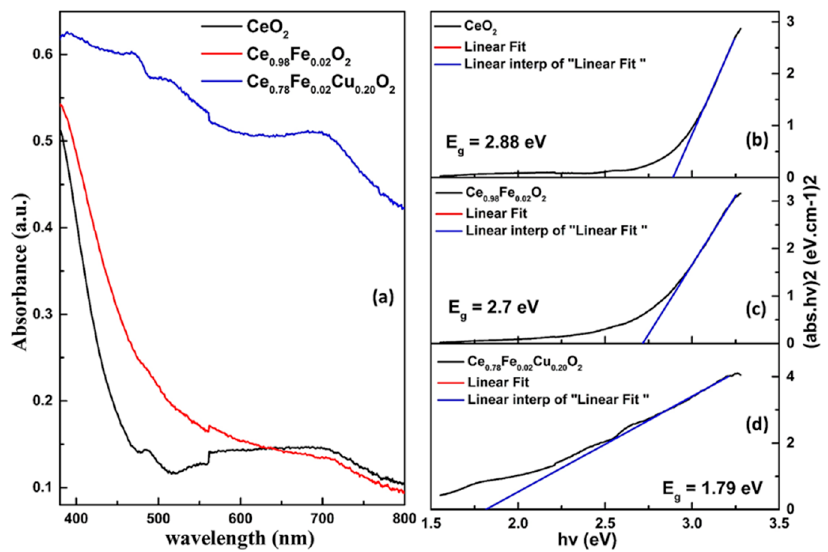
Figure 3. ( a ) UV–Vis absorption spectra of pure CeO 2 , Ce 0.98 Fe 0.02 O 2 , and Ce 0.78 Fe 0.02 Cu 0.20 O 2 nanoparticles. Tauc’s plot of ( b ) pure CeO 2 nanoparticles, ( c ) Ce 0.98 Fe 0.02 O 2 , and ( d ) Ce 0.78 Fe 0.02 Cu 0.20 O 2 .